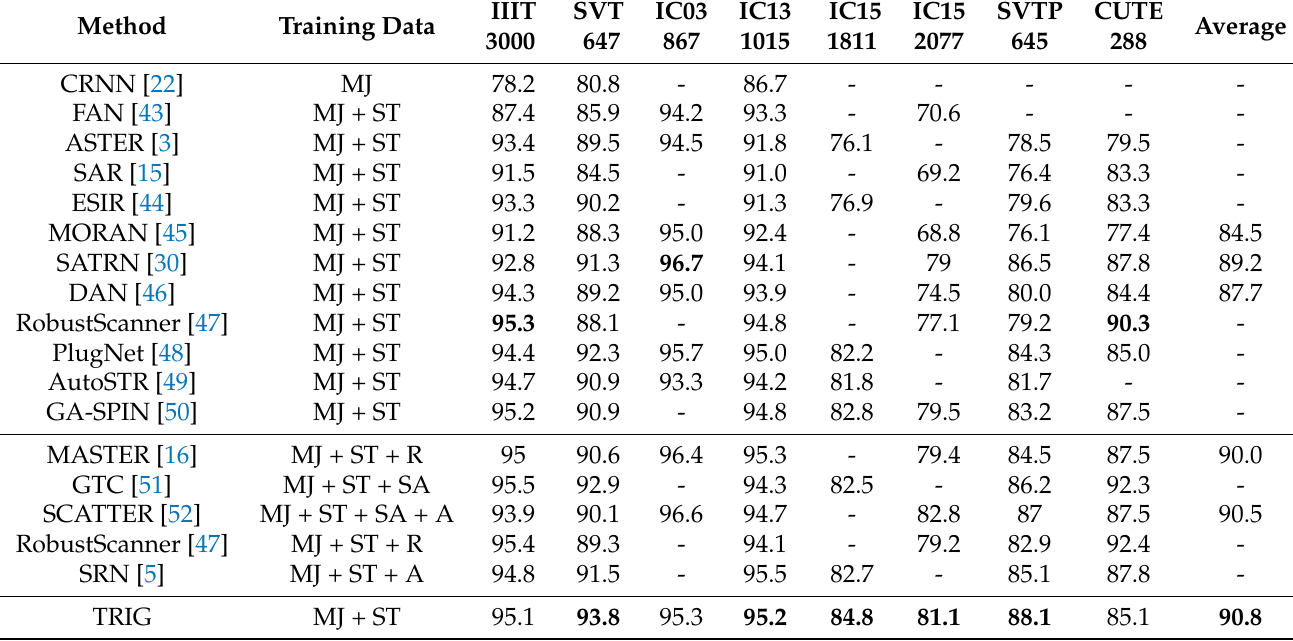
Table 1. Comparison with SOTA methods. ’SA’, ’R’ indicates using SynthAdd dataset or real datasets apart from MJ and ST. ’A’ means using data augmentation when training. For a fair comparison, reported results using additional data or data augmentation are not taken into account. Top accuracy for each benchmark is shown in bold . The average accuracy is calculated on seven datasets and IC15 using the version which contains 2077 images.